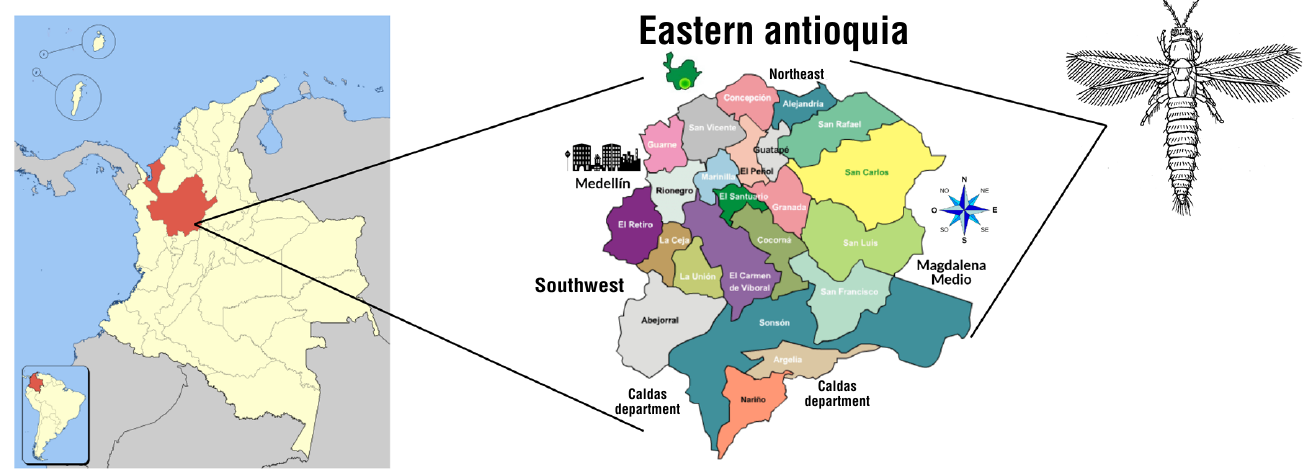
Figure 1. Map of the location of the studied area in Colombia, South